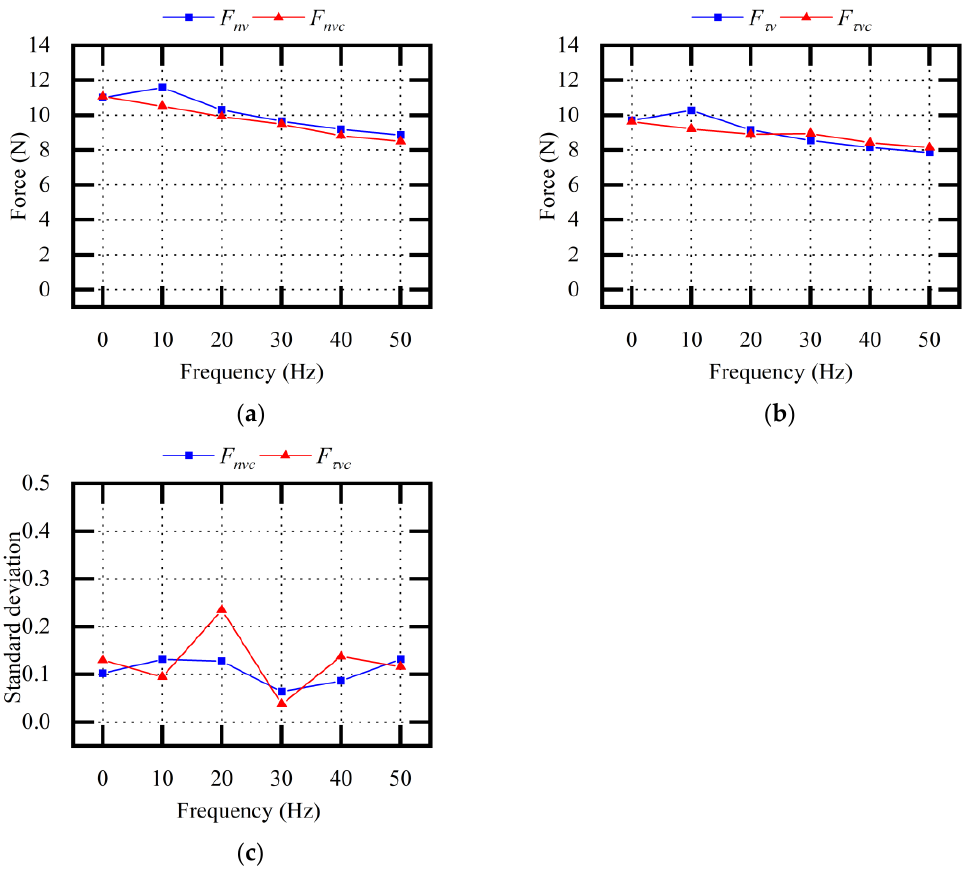
Figure 8. Comparative analysis of sawing forces (variable f ): ( a ) normal sawing force; ( b ) tangential sawing force; ( c ) standard deviation σ 1 of experimental values.